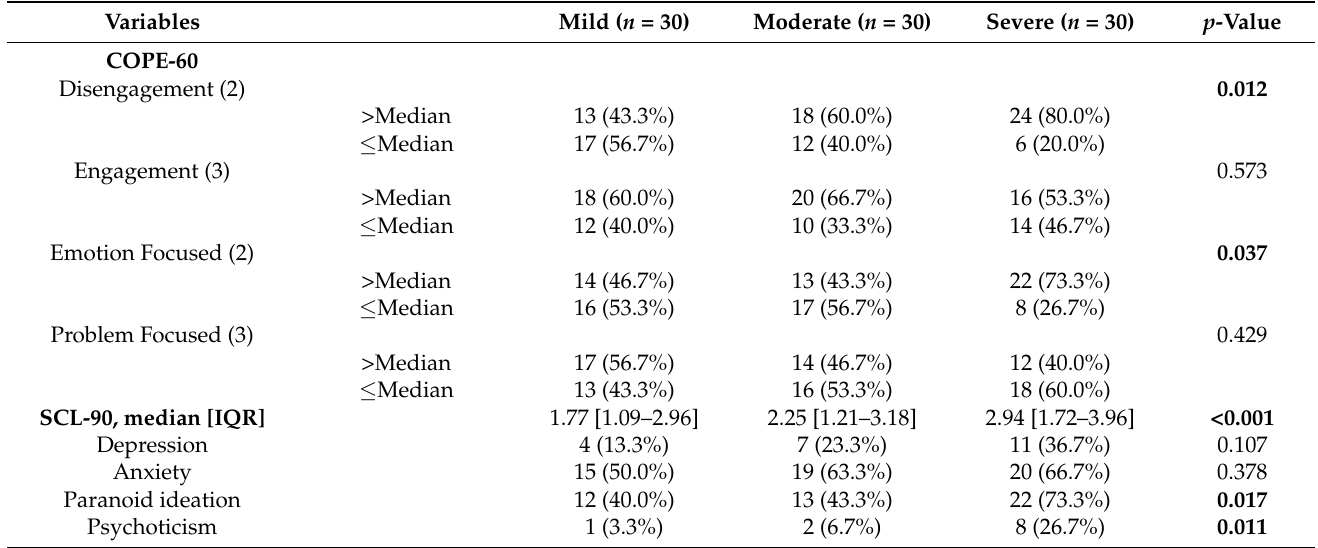
Table 4. Psychometric scale results of study participants by the severity of